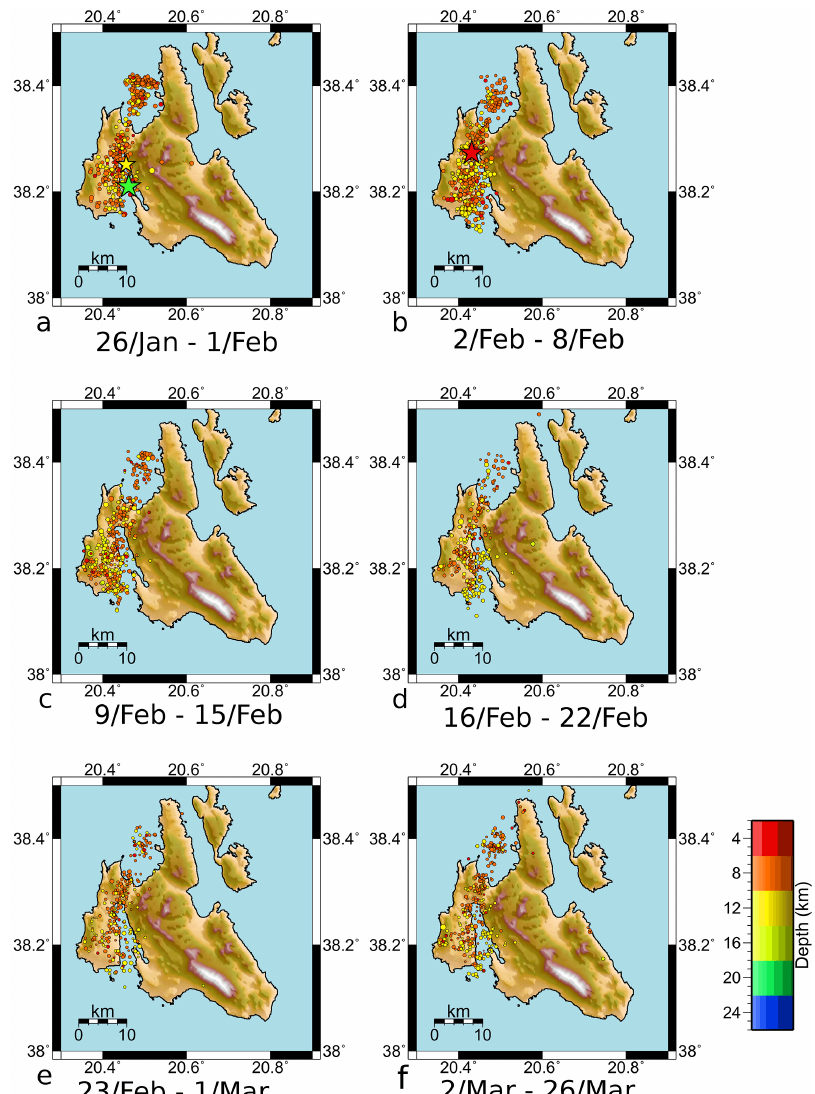
Figure 9. Space–time evolution of the Cephalonia 2014 sequence. The maps show the aftershocks with 1-week time interval (a–f) between 26 January 2014 and 26 March